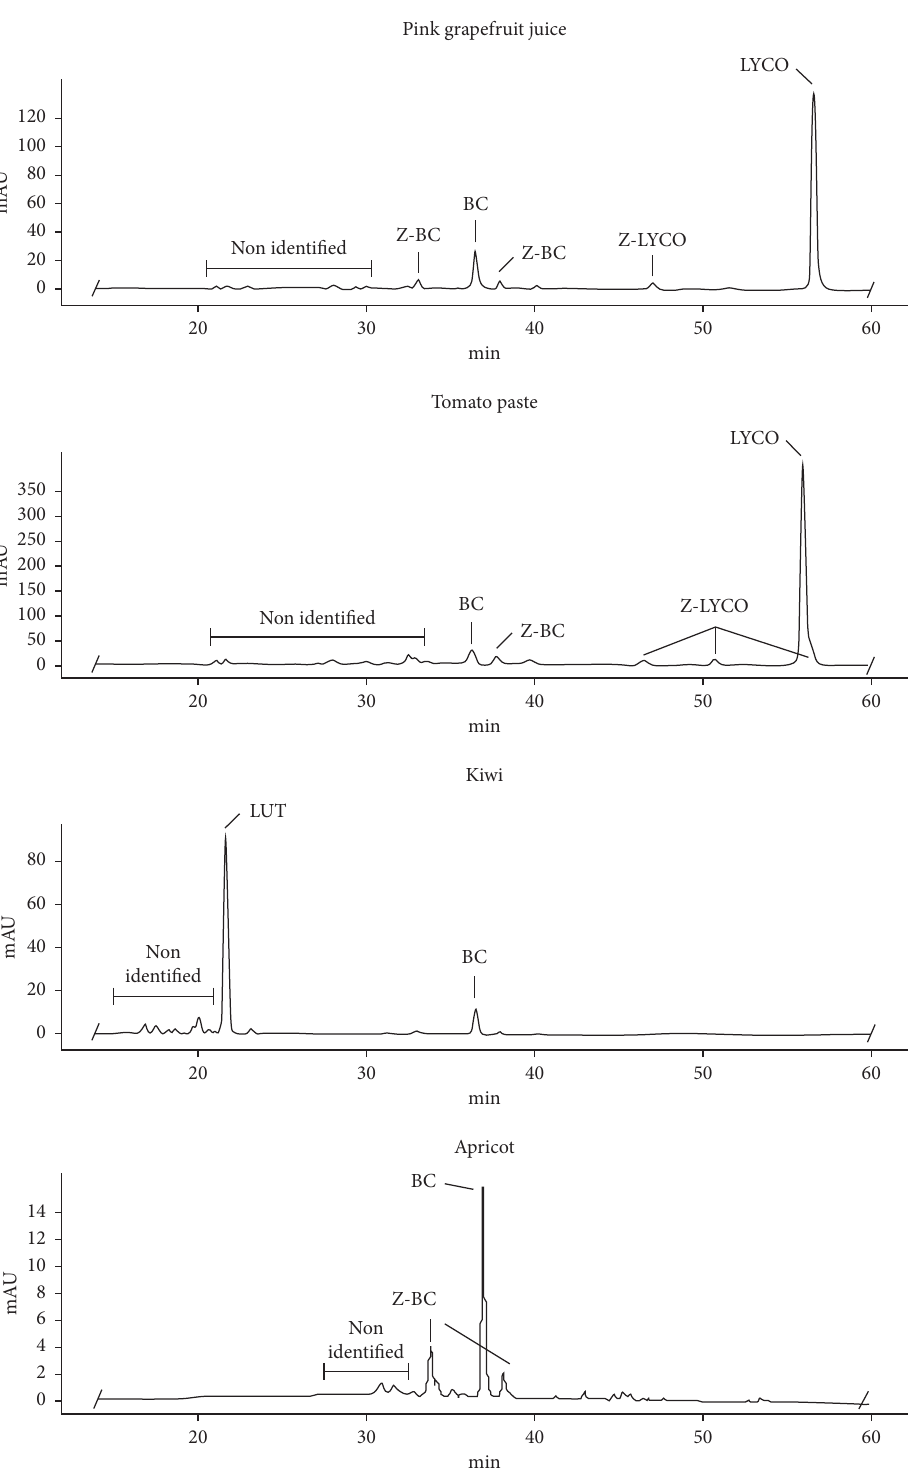
Figure 4: Chromatograms of the 5 fruit extracts measured at 450 nm. BC: all-E- β -carotene; LYC: all-E-lycopene; LUT: lutein; Z-BC: Z- β -carotene isomers; Z-LYC: Z-lycopene